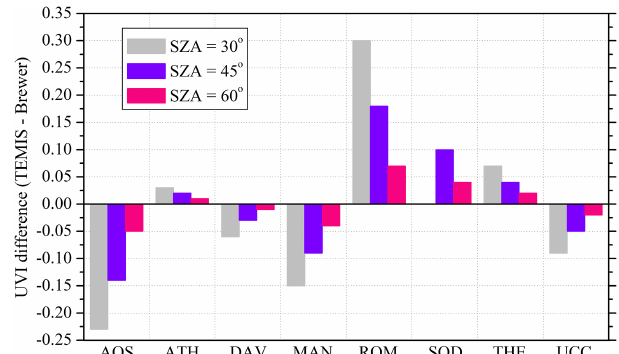
Figure 7. Differences of UVI derived by UVIOS using as input the TEMIS and Brewer TOC, respectively, at all stations with available data (lower possible SOD SZA is 44 ◦